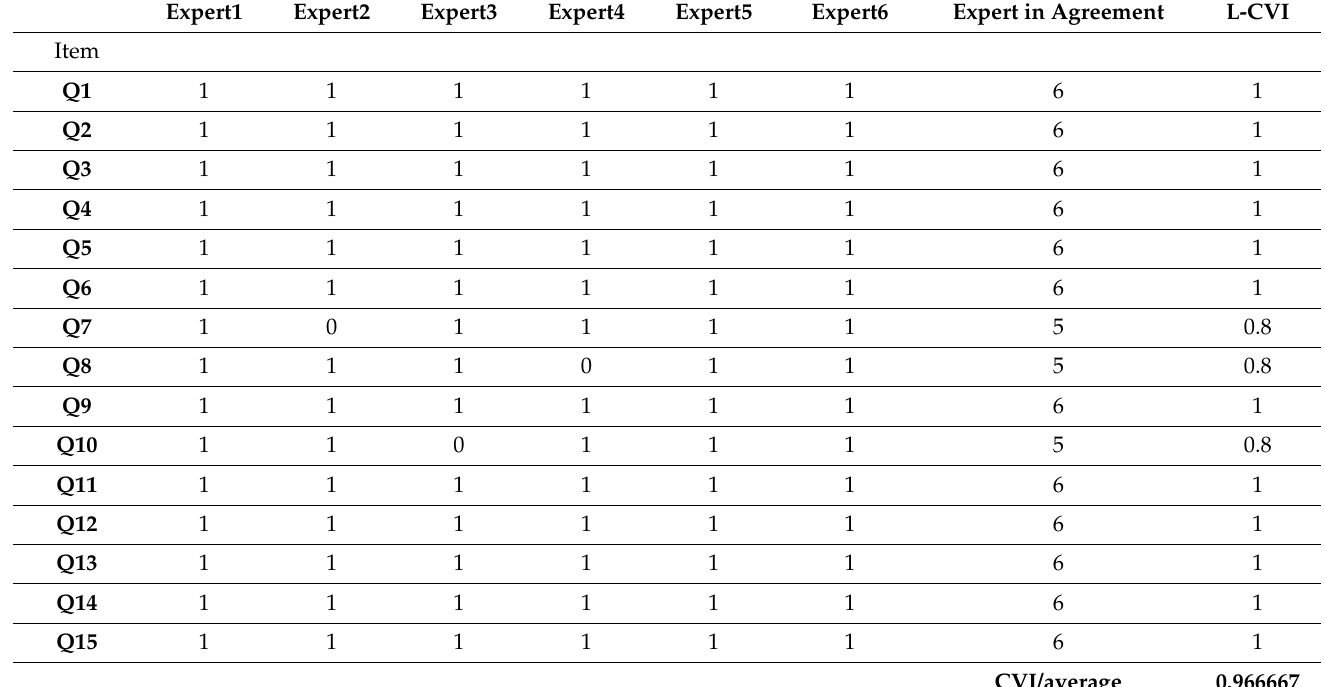
Table A1. Content Validity Index based on the rating of the relavance of items by six experts. Expert3 Expert4 Expert5 Expert6 Expert in